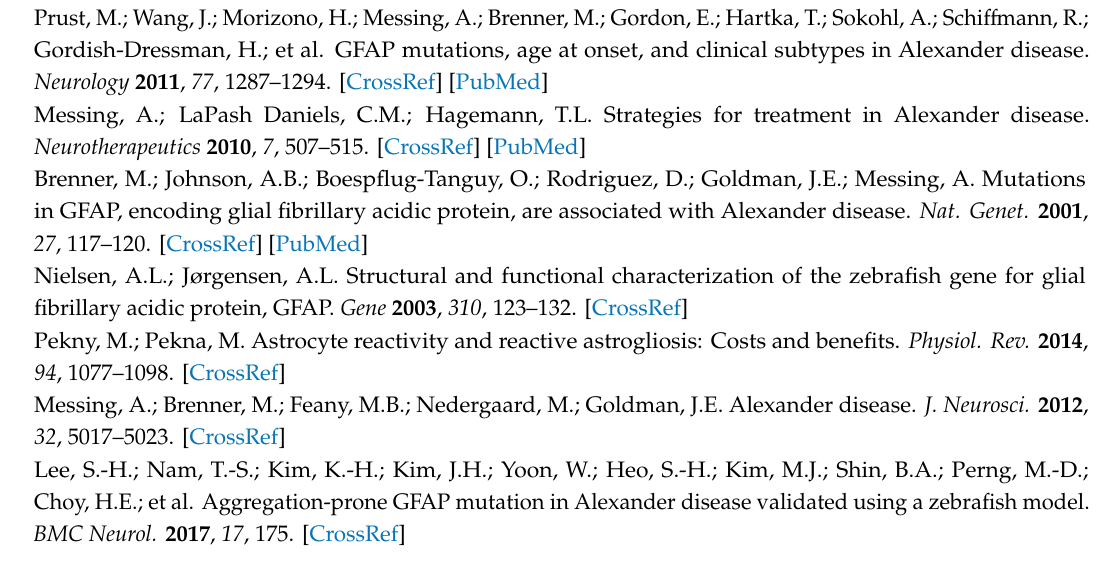
Figure S1. Aggregates quantification; Figure S2. Tests performed to evaluate ethanol and CEF healthy concentration on embryos; Figure S3. E ff ect of ceftriaxone (CEF) 1.0 mM on gfap promoter; Figure S4. E ff ects of thermal shock on p.R239C aggregates; Figure S5. Electron microscope analysis on wildtype embryo; Table S1. E ff ects of ceftriaxone (CEF) on p.R239C mutant embryos in one of the experiments, here shown as exemplary; Table S2. E ff ect of ceftriaxone (CEF) 1.0 mM on GFAP WT-GFP